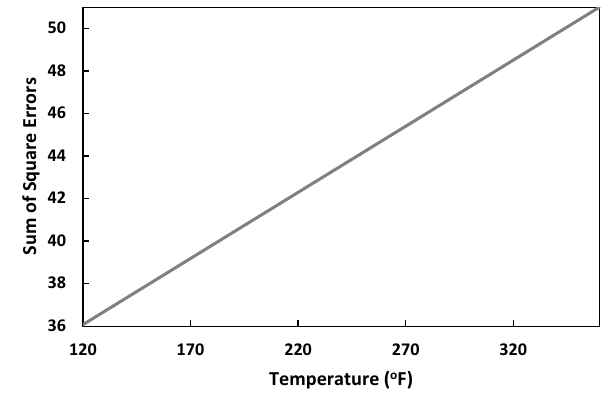
Fig. 11 The impact of formation temperature on the error between pseudo-pressure before and after